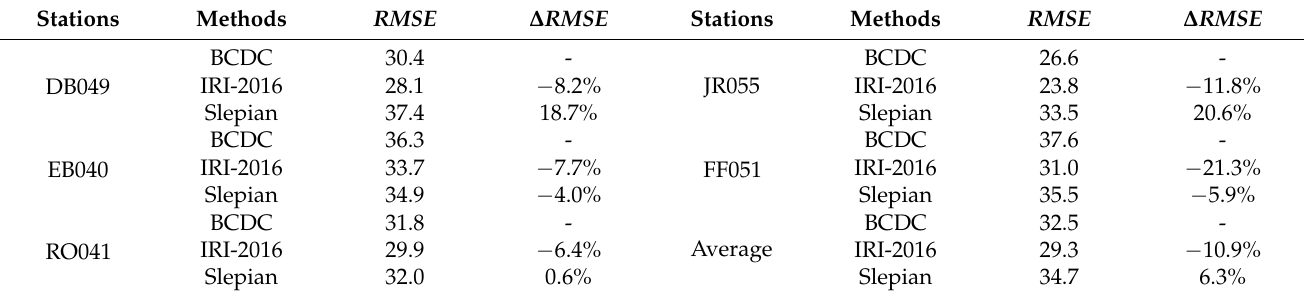
Table 3. The overall RMSE and ∆ RMSE of the H m F 2 parameter (unit: km) achieved by the three methods.